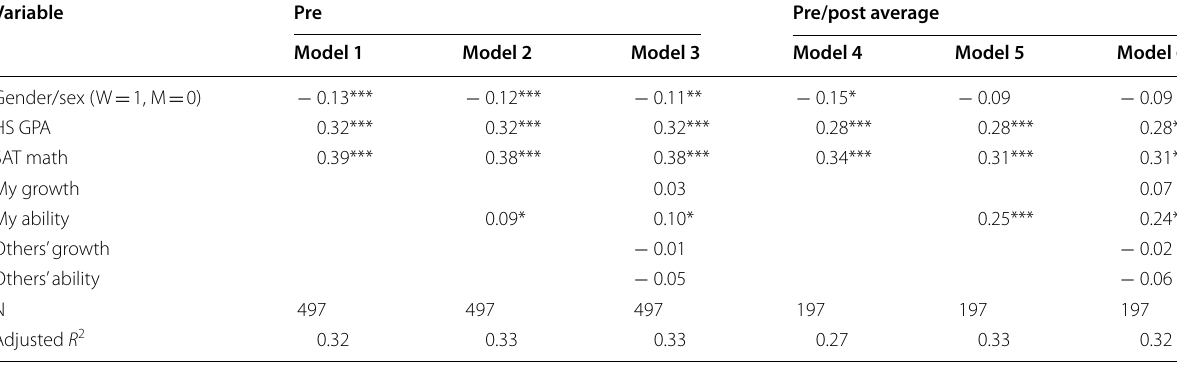
This table shows standardized regression coefficient ( β ) values of multiple regression analysis predicting Physics 1 course grade using pre-survey responses (Models 1–3) and an average of pre- and post-survey responses (Models 4–6). Adjusted R 2 and N are reported for each